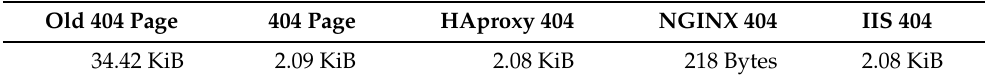
Table 1. 404 page